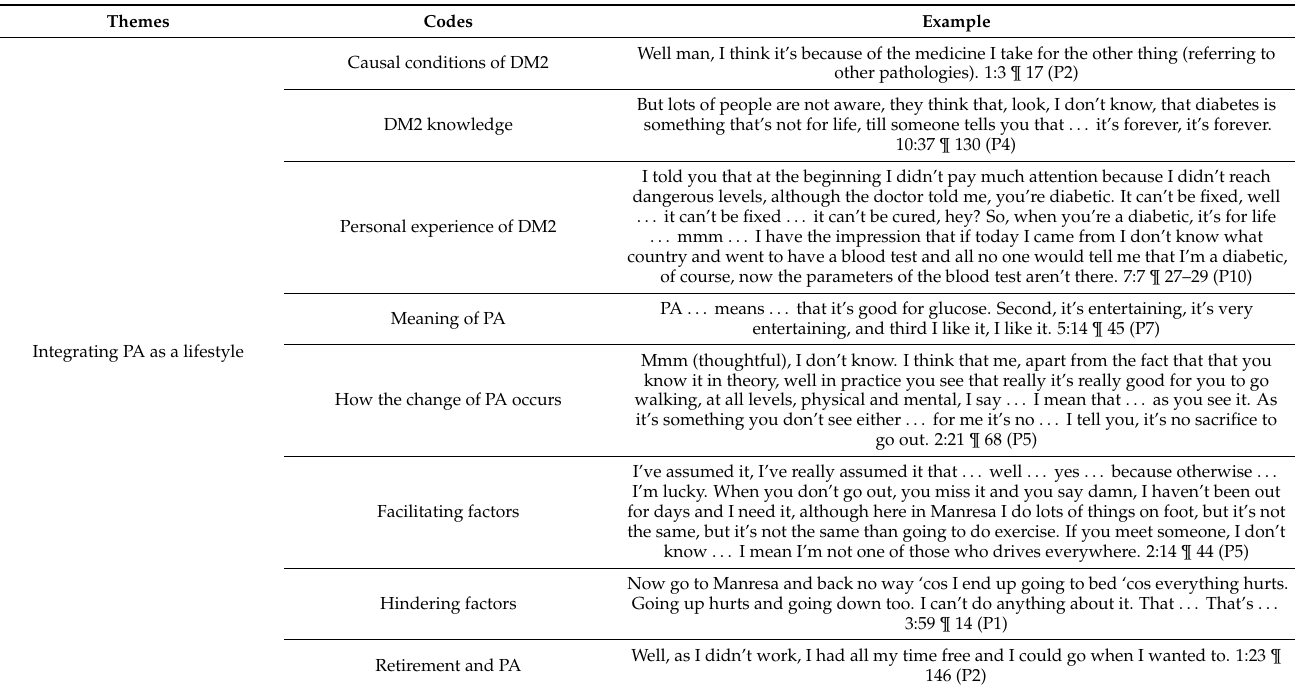
Table 2. Inductive analysis themes and